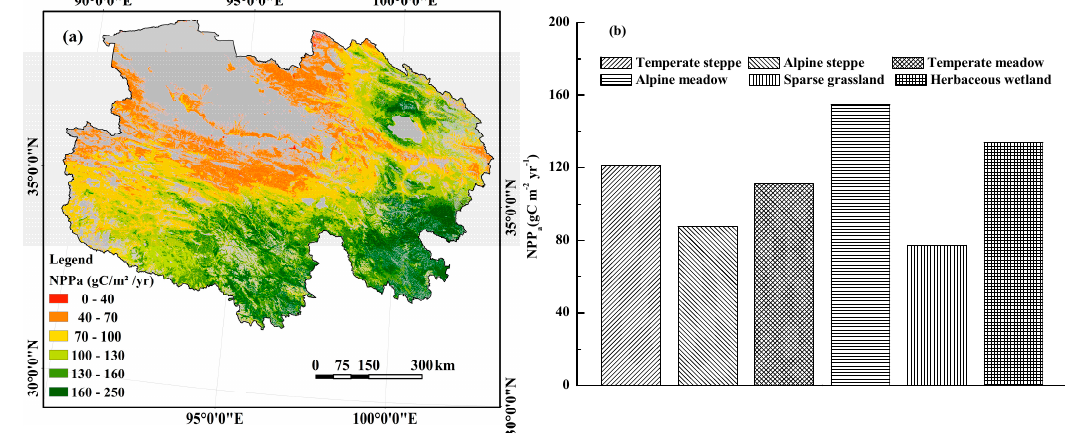
Figure 3. Spatial pattern of the mean annual ( a ) and NPP a for the different grassland types ( b ) from 2001 to 2016 in Qinghai province.